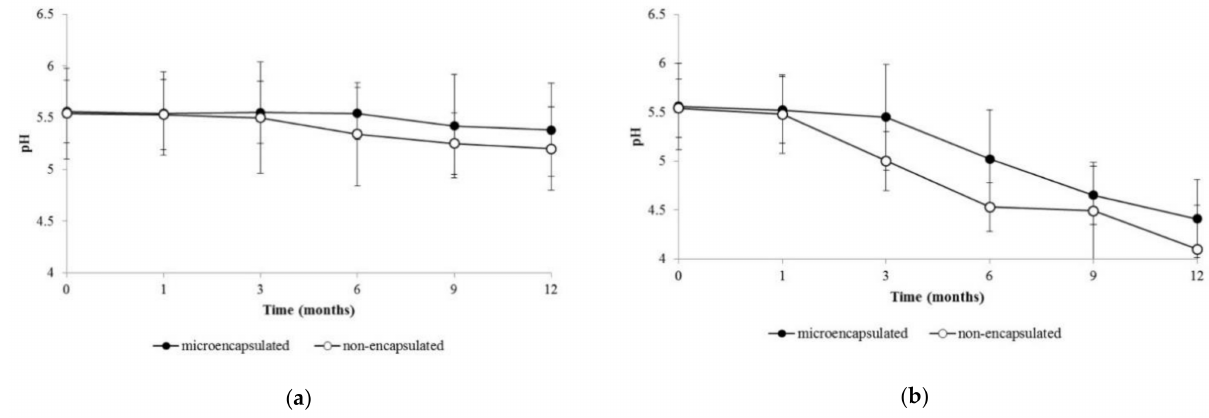
Figure 3. pH measurements of the microencapsulated and non-encapsulated formulations. ( a ) Stored at 25 ± 2 ◦ C/60% ± 5% RH; ( b ) stored at 40 ± 2 ◦ C/75% ± 5% RH. The results are represented as mean ± SD.